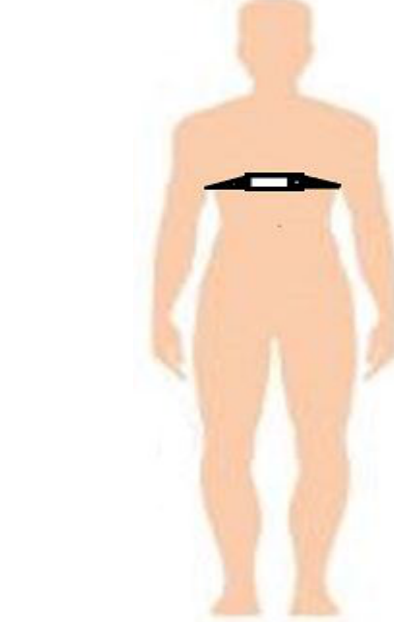
Figure 5. Sensor distribution. ( left ) Device position and ( right ) device (7) placement.